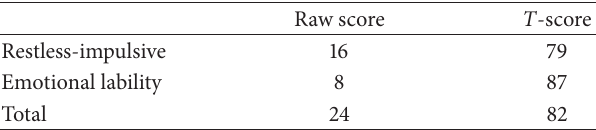
Table 3: Connors Early Childhood Global Index scores. Raw score T -score 16